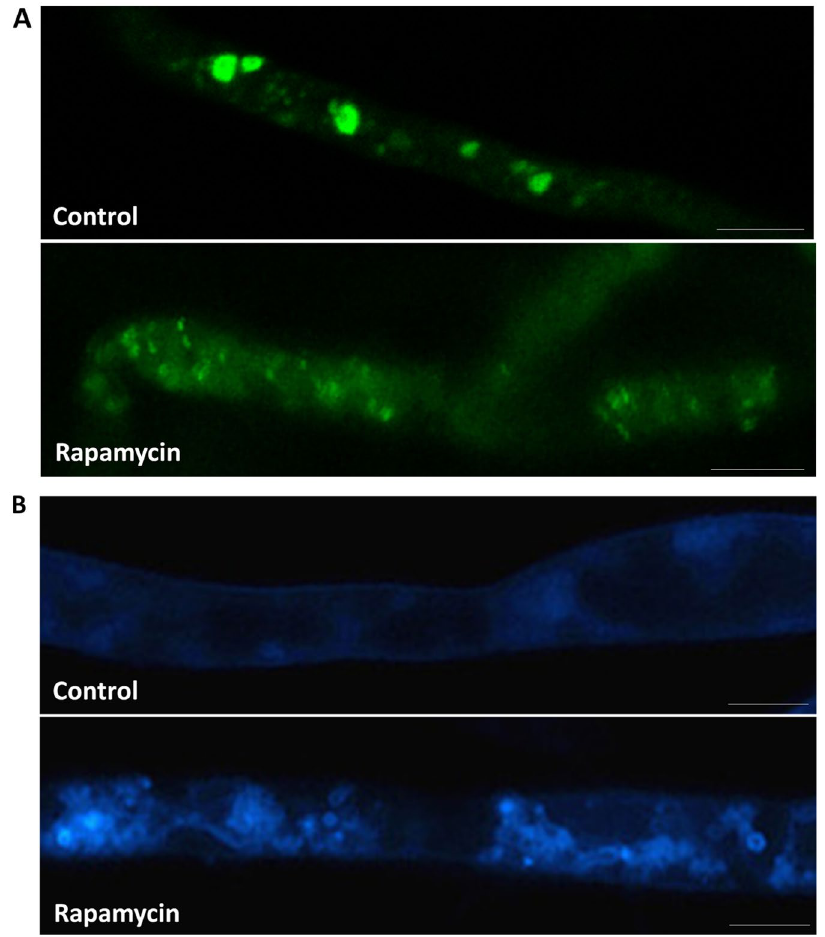
100 nM rapamycin or DMSO (control) for 4 h, hyphae were analyzed by confocal microscopy. Bars = 10 μ m. ( B ) Autophagy indicated by MDC dye. P. sojae wild-type hyphae were incubated in 10% V8 juice. After treated with 100 nM rapamycin or DMSO (control) for 4 h, hyphae samples concurrently stained with MDC were analyzed by confocal microscopy. Bars = 10 μ